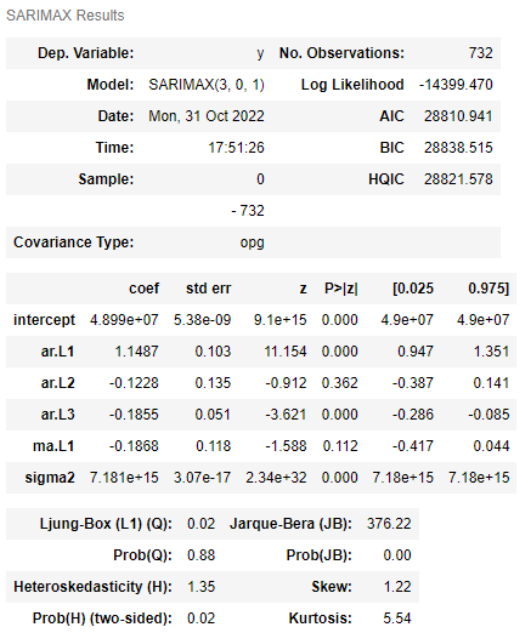
Figure 18. The SARIMA model summary.